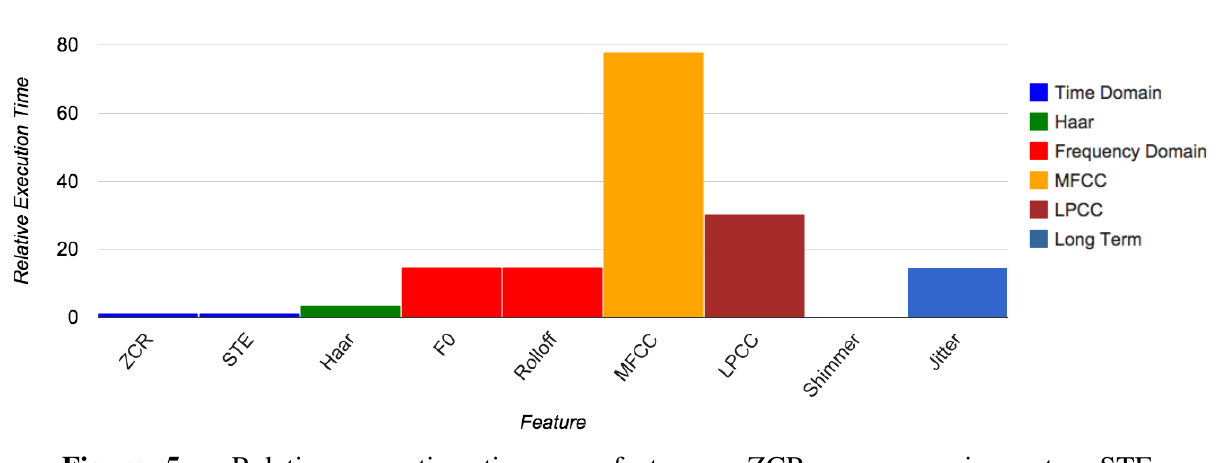
Figure 5. Relative execution time per feature. ZCR, zero crossing rate; STE, short-time energy; F0, base